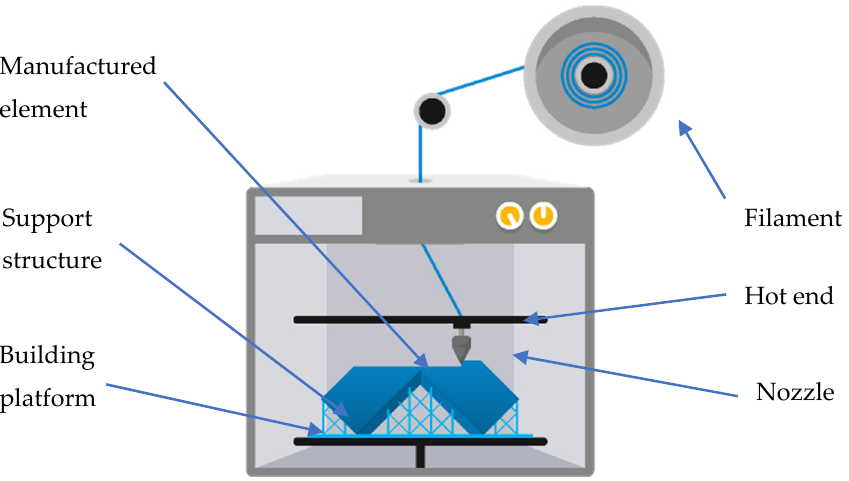
Figure 1. The FFF additive technology process scheme [25].